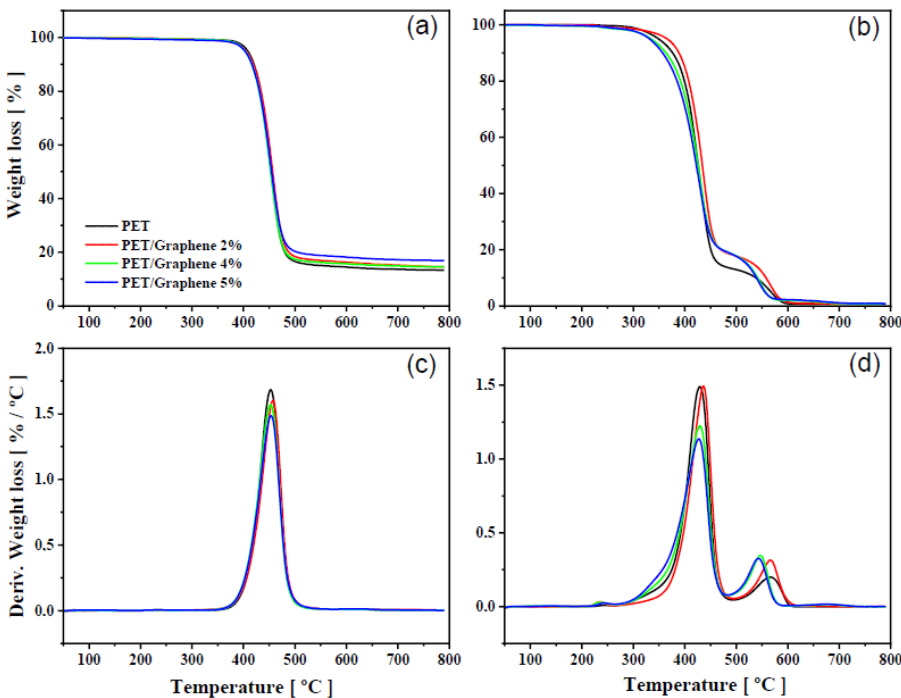
Figure 6. TGA and dTGA curves for PET and PET/graphene nanocomposites with different graphene loadings under nitrogen ( a , c ) and air ( b , d ) atmospheres. Heating scan = 5 °C·min −1 .